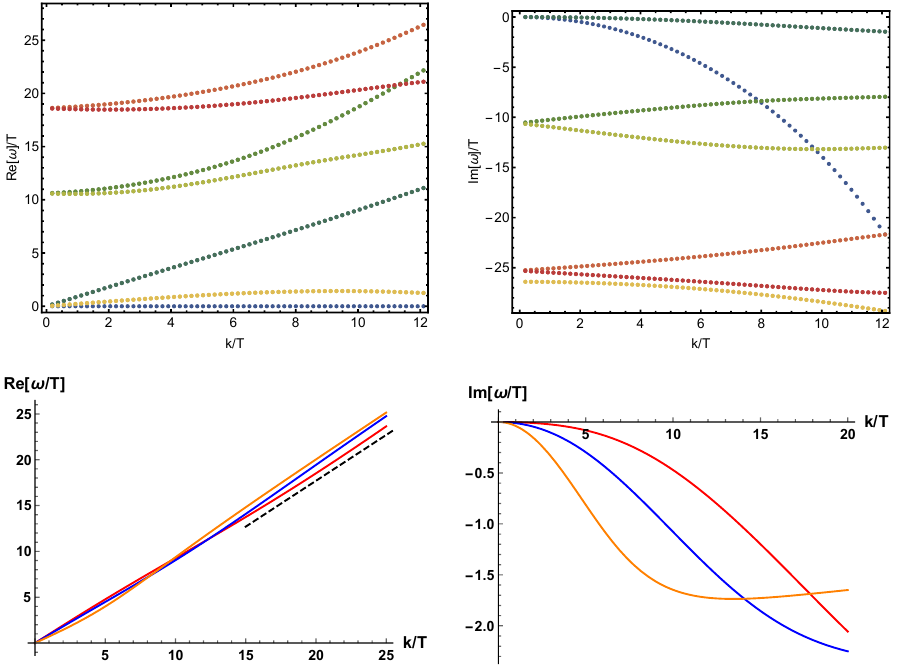
Figure 13 . Top panel: the full spectrum of QNMs for (cid:12)xed temperature m=T = 0 : 179. Bottom panel: the dispersion relation of the longitudinal sound mode beyond the hydrodynamic limit. In the hydrodynamic limit, k=T (cid:28) 1, the behaviour is described by (3.1). At large momenta, i.e. for k=T (cid:29) 1, the real part of the frequency asymptotes to the UV dispersion relation Re( ! ) = (cid:6) k indicated by the dashed black line. The imaginary part of the frequency is small compared to the real part even for large momenta.